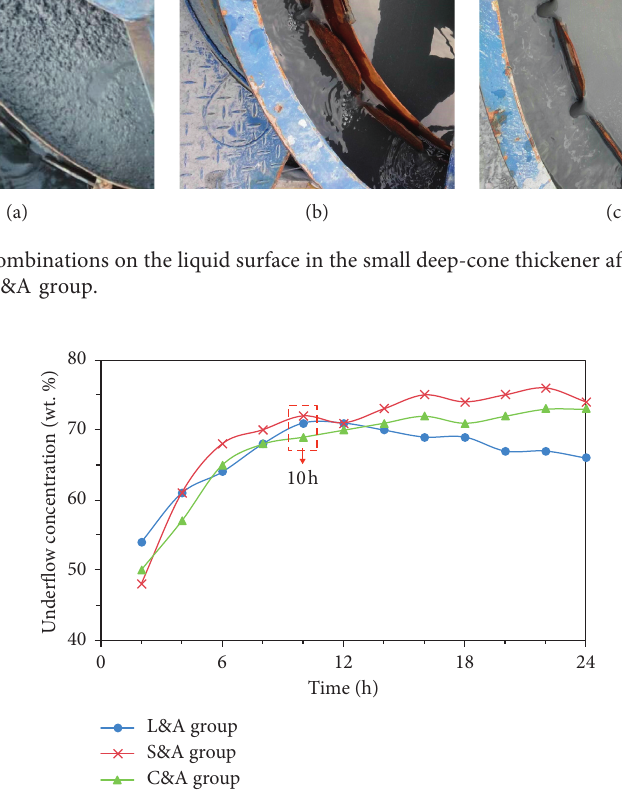
Figure 12: Variation of underflow concentration of different combinations with